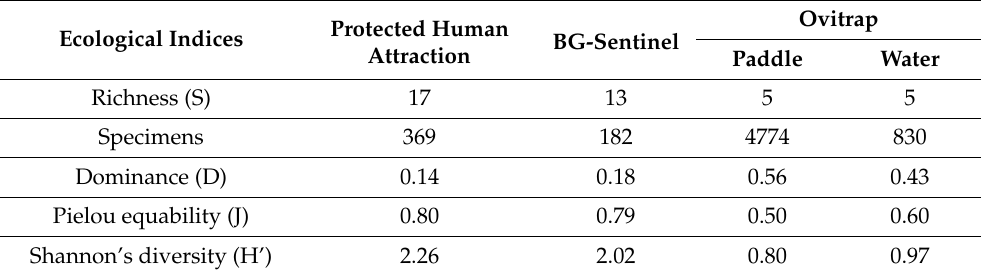
Table 2. Ecological indices according to each mosquito collection method at the Centro de Primatolo- gia do Rio de Janeiro from December 2018 to December